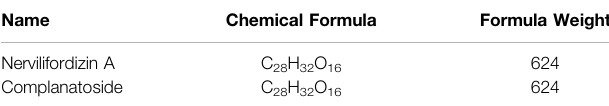
TABLE 2 | The standard reference substance for TFENF.